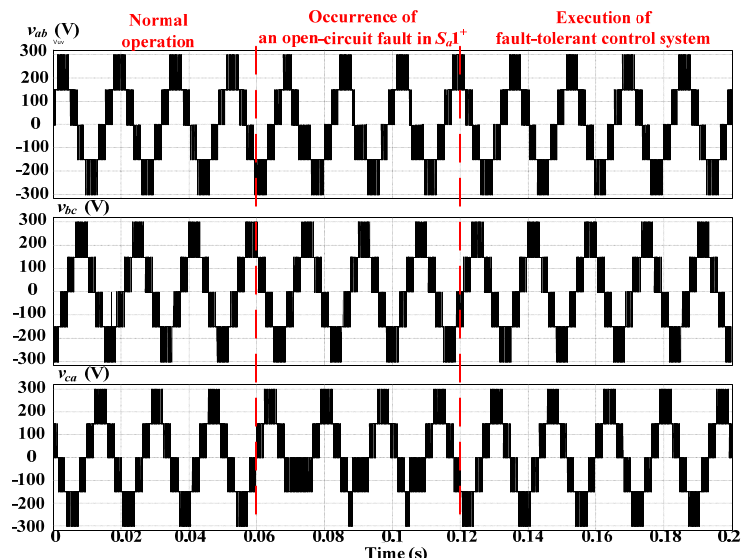
Figure 13. The output voltage of S a 1 + after the occurrence of an open-circuit fault and the activation of fault-tolerant control.